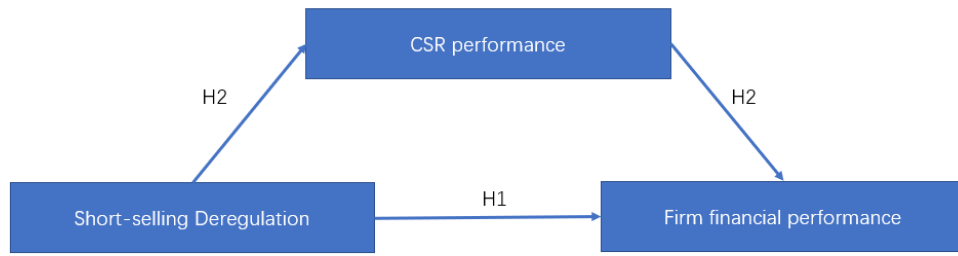
Figure 1. Research Figure 1. Research framework.